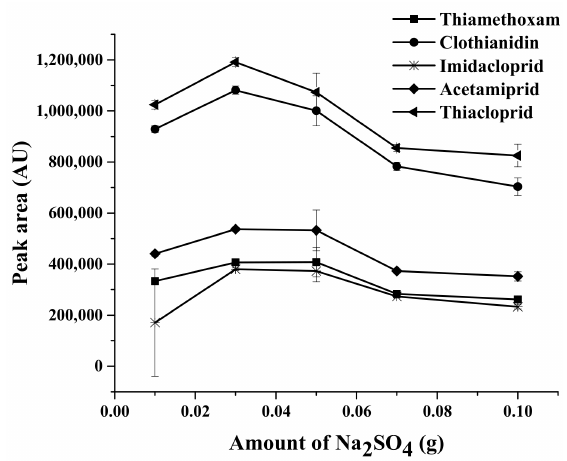
Figure 3. Effect of amount of Na 2 SO 4 on the extraction efficiency, using 30 mg MMT sorbent, sample volume of 13 mL, and 200 µ L of acetonitrile as desorption solvent.